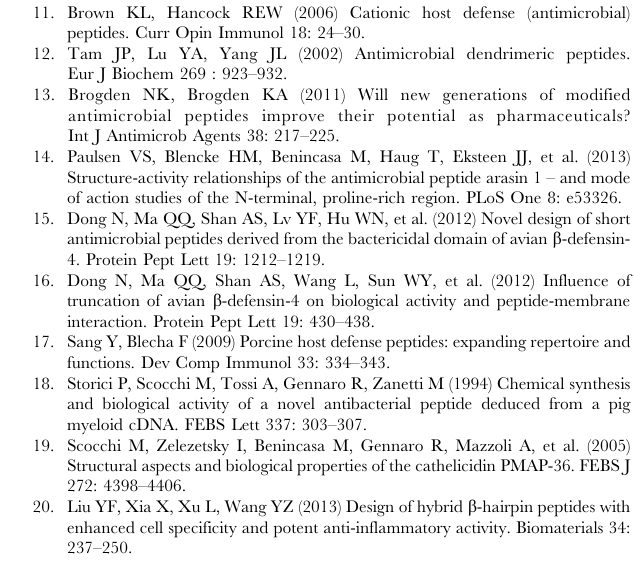
Figure S1 Tryptophan fluorescence emission spectra of PMAP-36 (A), GI24 (B), and melittin (C) in the buffer or in the presence of PE/PG or PC/cholesterol liposomes. Figure S2 Stern–Volmer plots for the quenching of Trp fluorescence of PMAP-36 (A), GI24 (B), and melittin (C) by acrylamide in the buffer or in the presence of PE/PG or PC/cholesterol